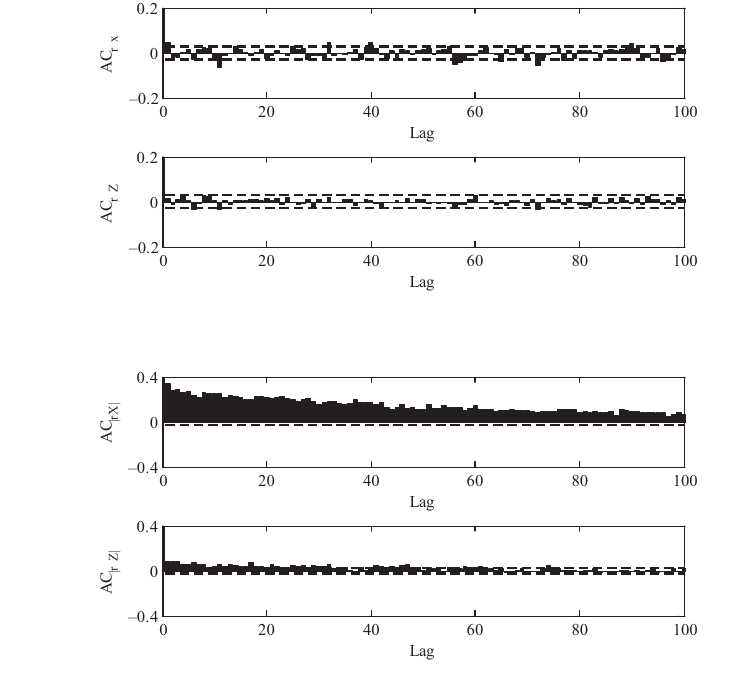
Figure 5. Autocorrelation in raw returns of the two markets